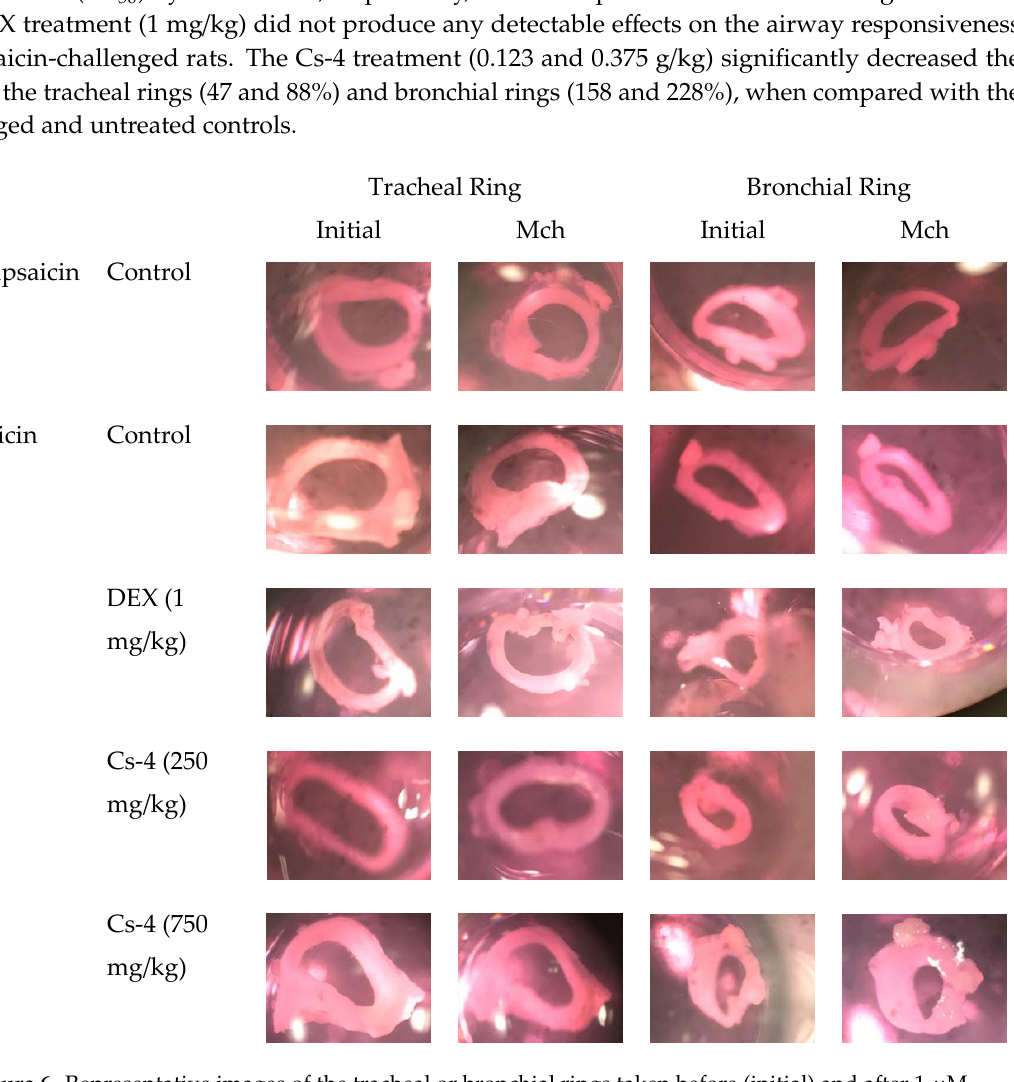
Figure 6. Representative images of the tracheal or bronchial rings taken before (initial) and after 1- μM methacholine (Mch) was added.